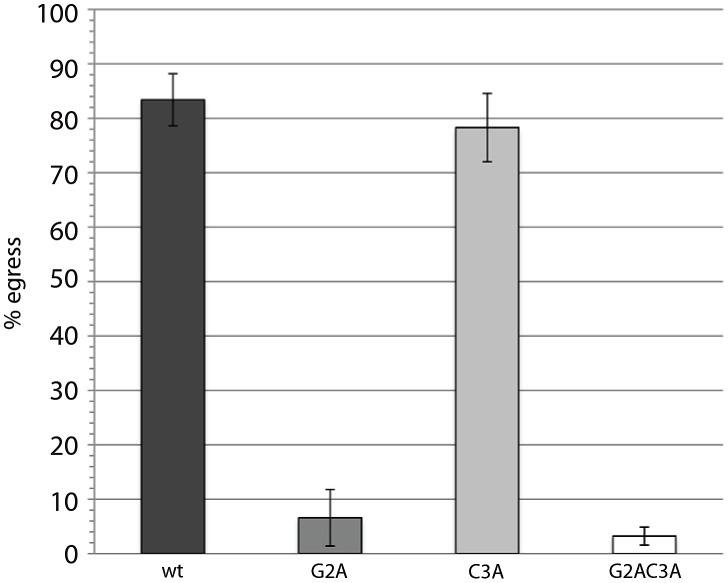
Activity of TgCDPK3 requires putative acylated residues in the consensus N-terminal motif.ΔTgCDPK3 parasites transfected with the wild-type (TgCDPK3wt) or palmitoylation mutant (TgCDPK3C3A) ectopic copies of TgCDPK3 show wild-type levels of egress, following stimulation with A23187, indicating successful complementation. Complementation with myristoylation (TgCDPK3G2A) or double mutants (TgCDPK3G2AC3A) is not successful. Error bars = ± s.d.